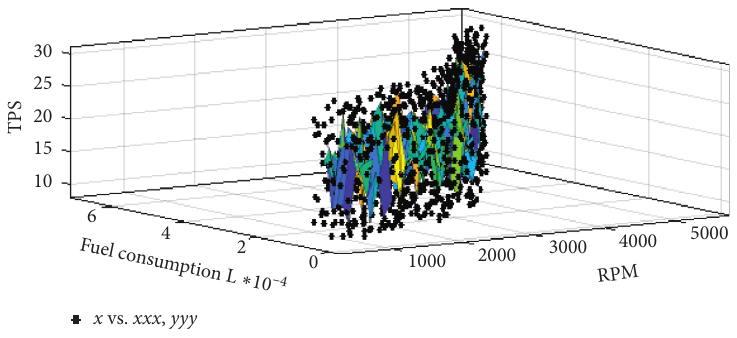
Figure 6: Estimated fuel consumption vs. RPM vs. TPS.